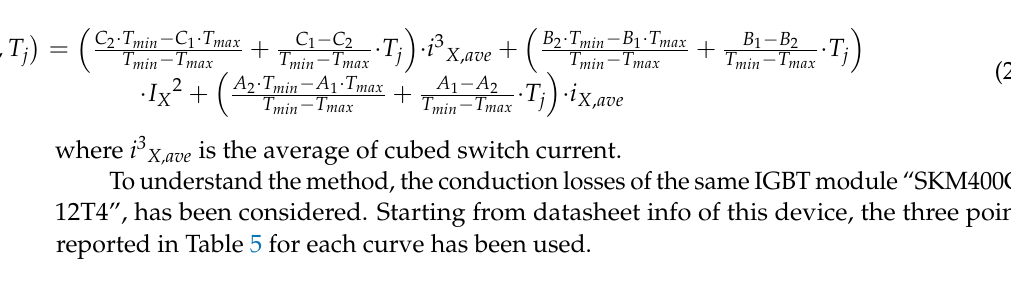
Table 5. Measurement points to characterize the conduction losses.